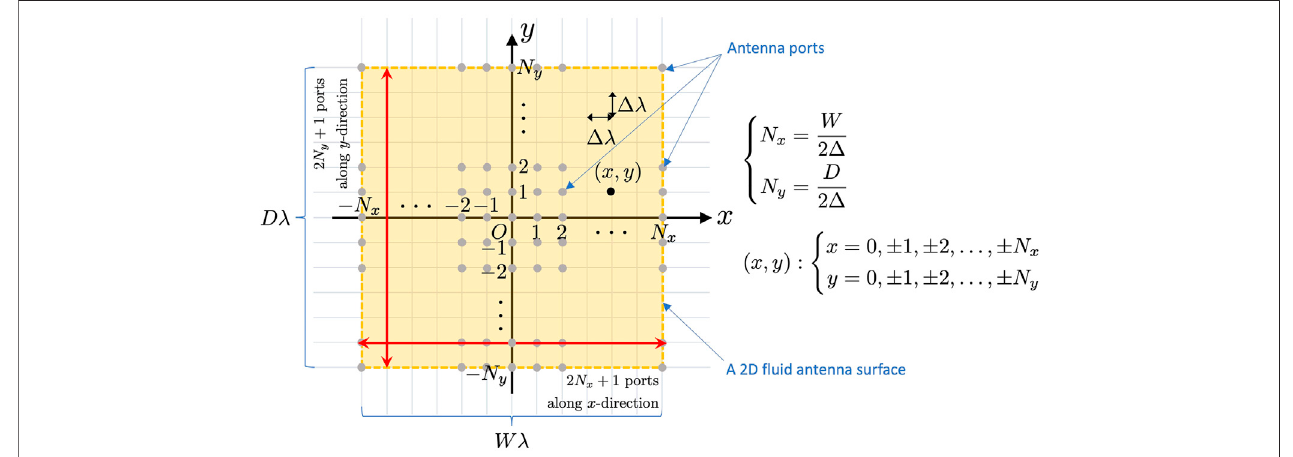
FIGURE6| Thecoordinatesystemthatweusetocharacterize the2D fl uidantennasurfaceofdimensions W λ × D λ ,wherethereare(2 N x +1)(2 N y +1)portsforthe fl uid radiator to be